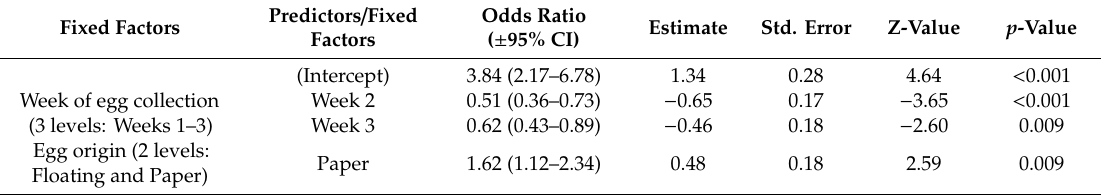
Table 3. E ff ects of week of egg collection and egg origin on egg hatch for Aedes albopictus